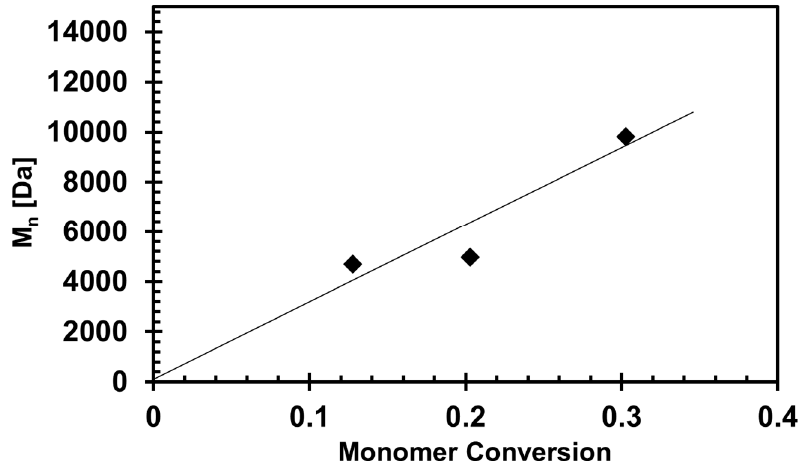
Figure 4. Evolution of M n for the NMC of STY/DVB in scCO 2 at [TEMPO]/[BPO] = 1.1, [DVB] = 1.5 wt.%, T = 120 °C, and P = 207 bar.